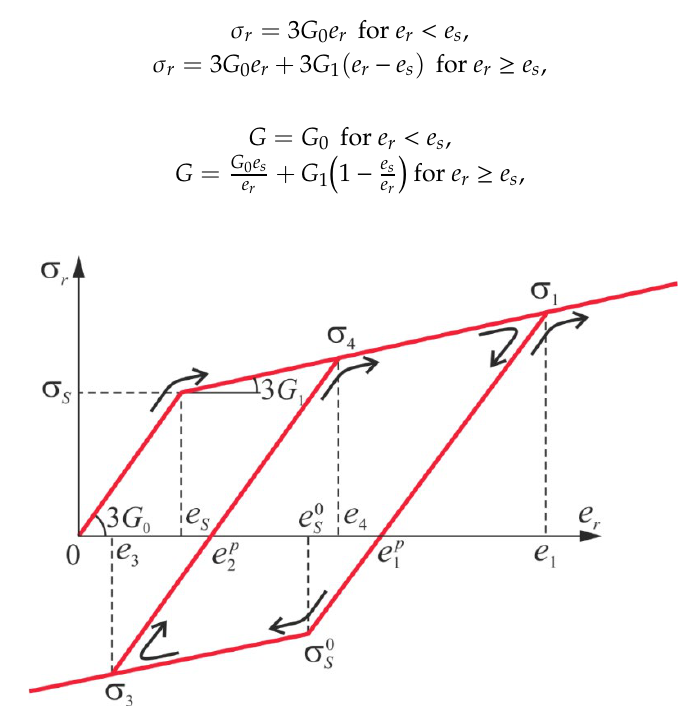
Figure 3. Dependence σ r ( e r ) constructed based on formulas (21) and (22).